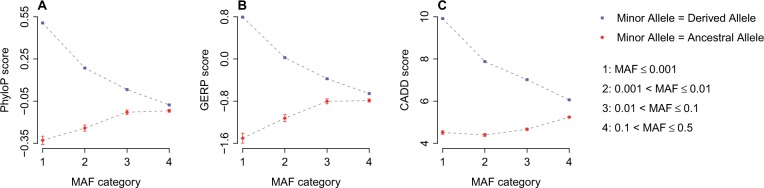
Correlation between MAF of exonic SNPs and corresponding conservation/pathogenicity score. (A) Relationship between MAF and PhyloP score; (B) Relationship between MAF and GERP score; (C) Relationship between MAF and CADD score. Each point represents the mean of the corresponding category. Error bars indicate the standard error of the mean.